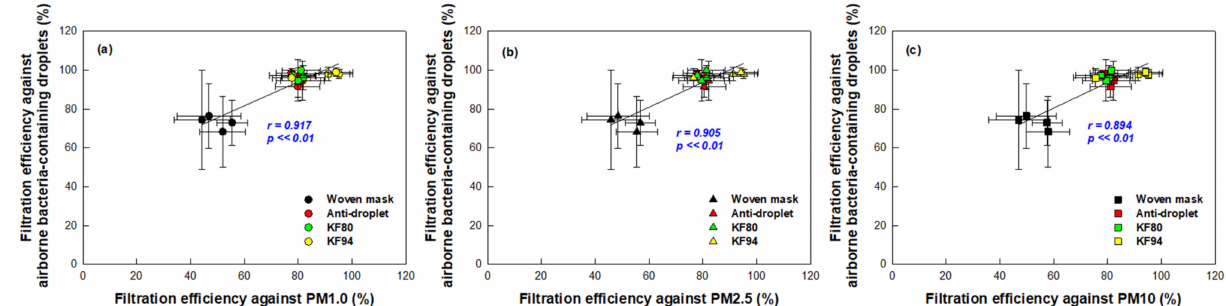
Figure 7. Pearson correlations of the filtration efficiencies of masks against particulate matters (PMs) versus their filtration efficiencies against airborne bacteria-containing droplets. ( a ) PM1.0 versus airborne bacteria-containing droplets. ( b ) PM2.5 versus airborne bacteria-containing droplets. ( c ) PM10 versus airborne bacteria-containing